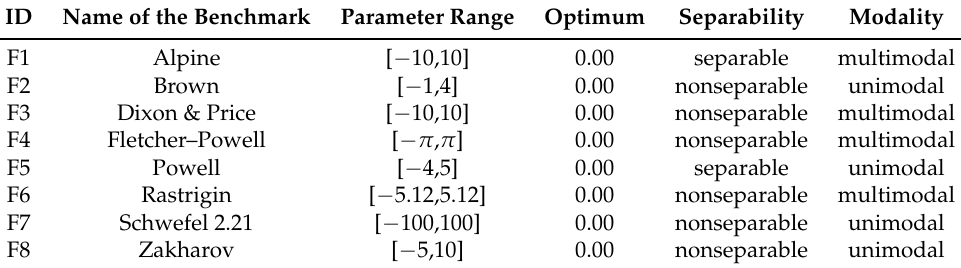
Table 1. Unconstrained benchmark function details.